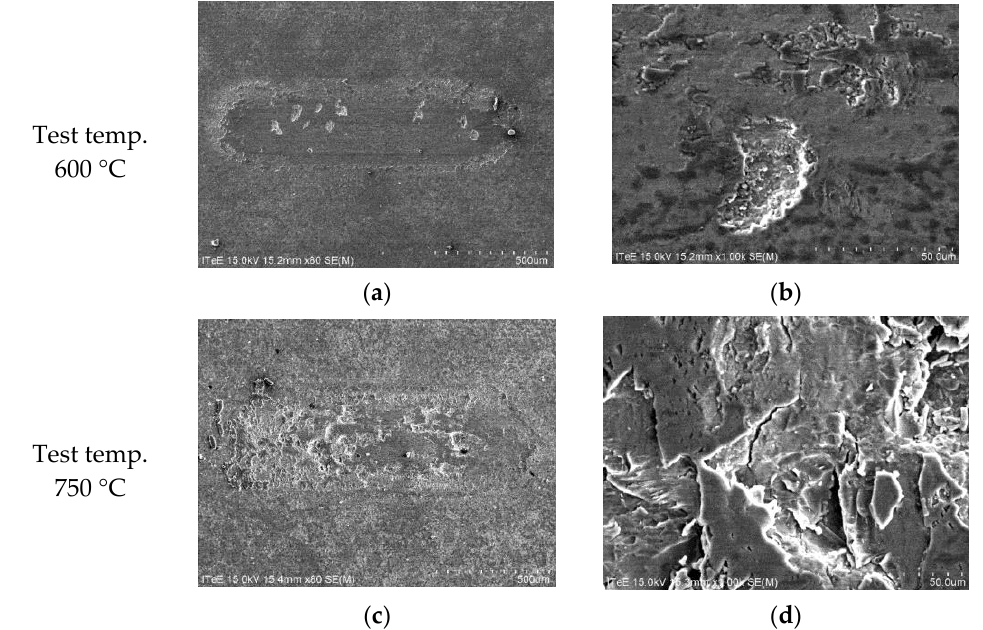
Figure 9. SEM micrographs presenting an overview of the contact zone on the disc made of Group I (Ti-TiB 2 ) composite without coating, sintering temp. 1250 °C: ( a ) 600 °C; ( b ) a magnified view, 600 °C; ( c ) 750 °C; ( d ) a magnified view, 750 °C.